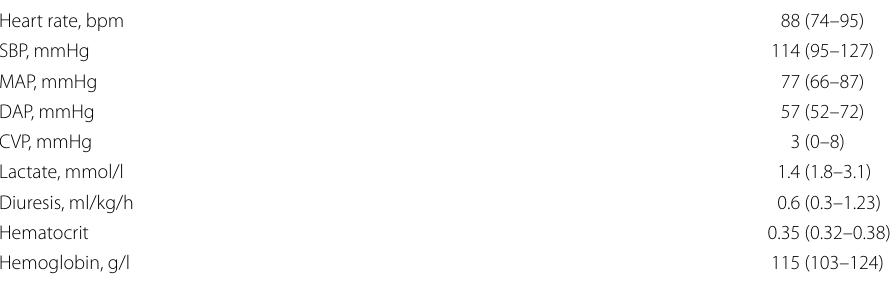
SBP, systolic blood pressure; DAP, diastolic arterial pressure; MAP, mean arterial pressure; CVP, central venous pressure Parameters were measured in immediate proximity to plasma volume measurement Data presented as median (IQR) except hematocrit which is described as fraction